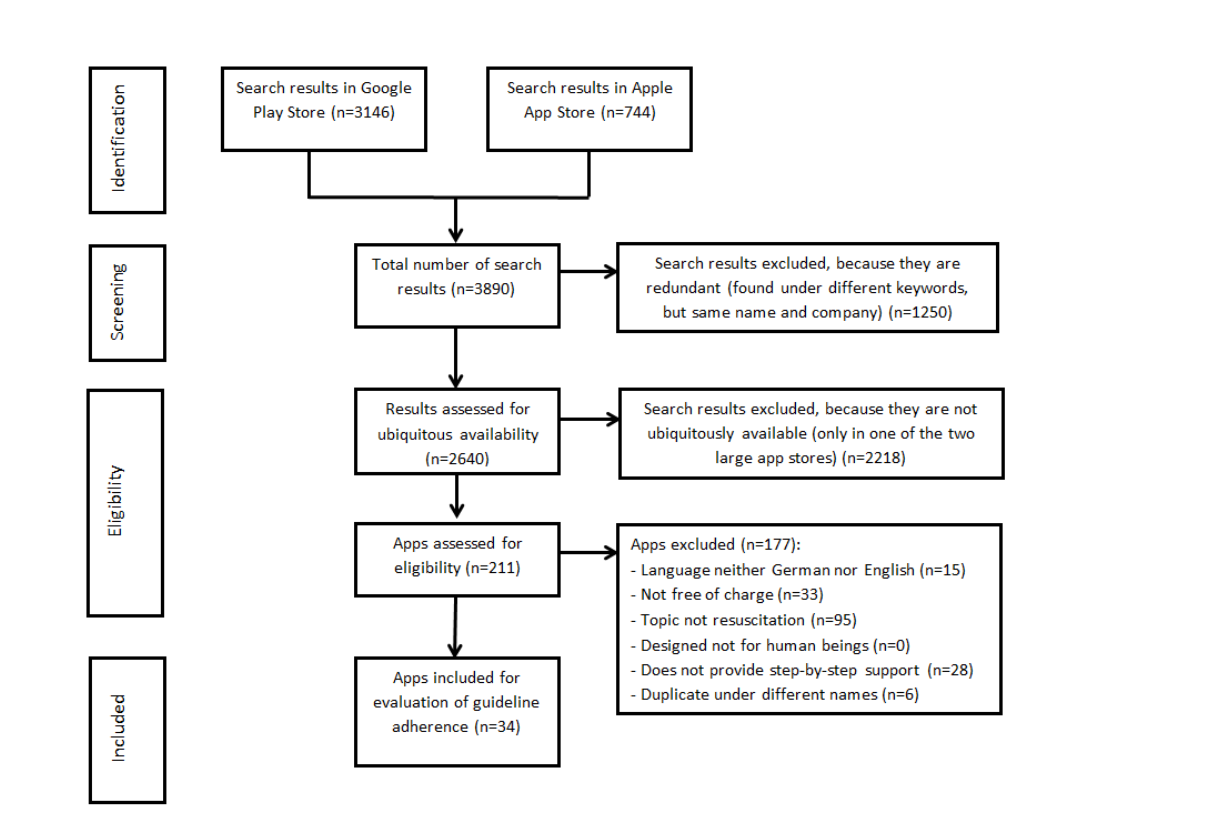
Figure 1. Results of the systematic review of apps providing step-by-step instructions for cardiopulmonary resuscitation (CPR) in case of a cardiac